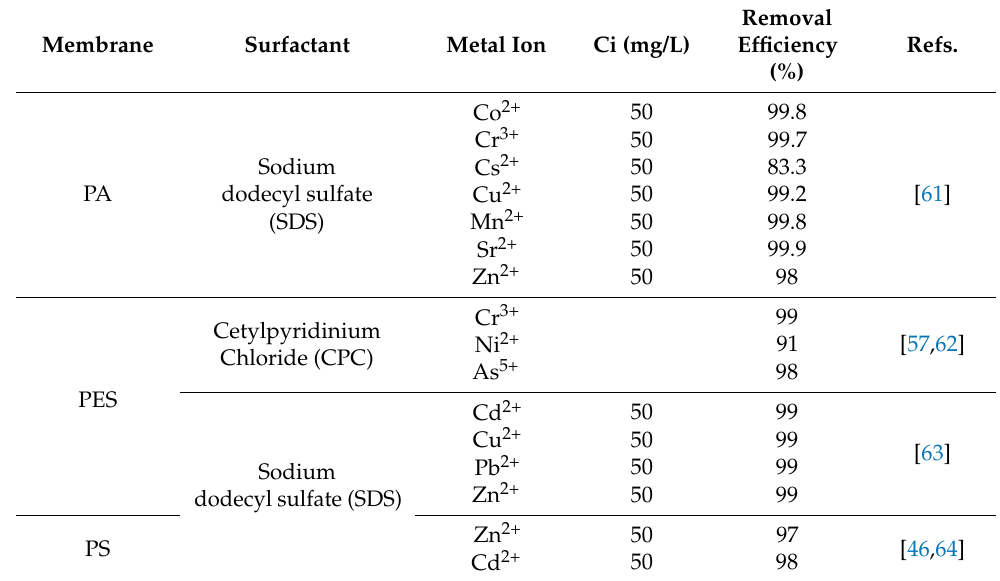
Table 2. Performance of MEUF in heavy metal